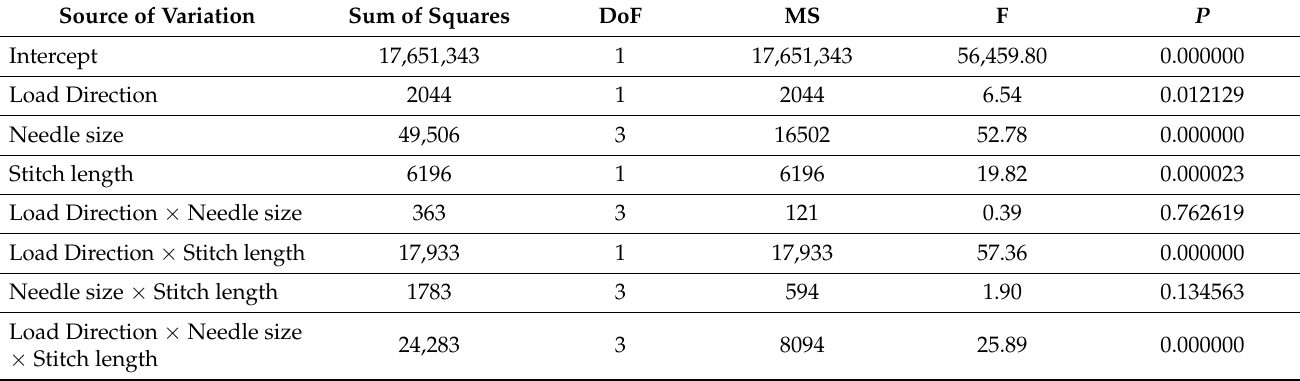
Table 4. Basic table of three-factor analysis of variance for strength of joints PVC faux